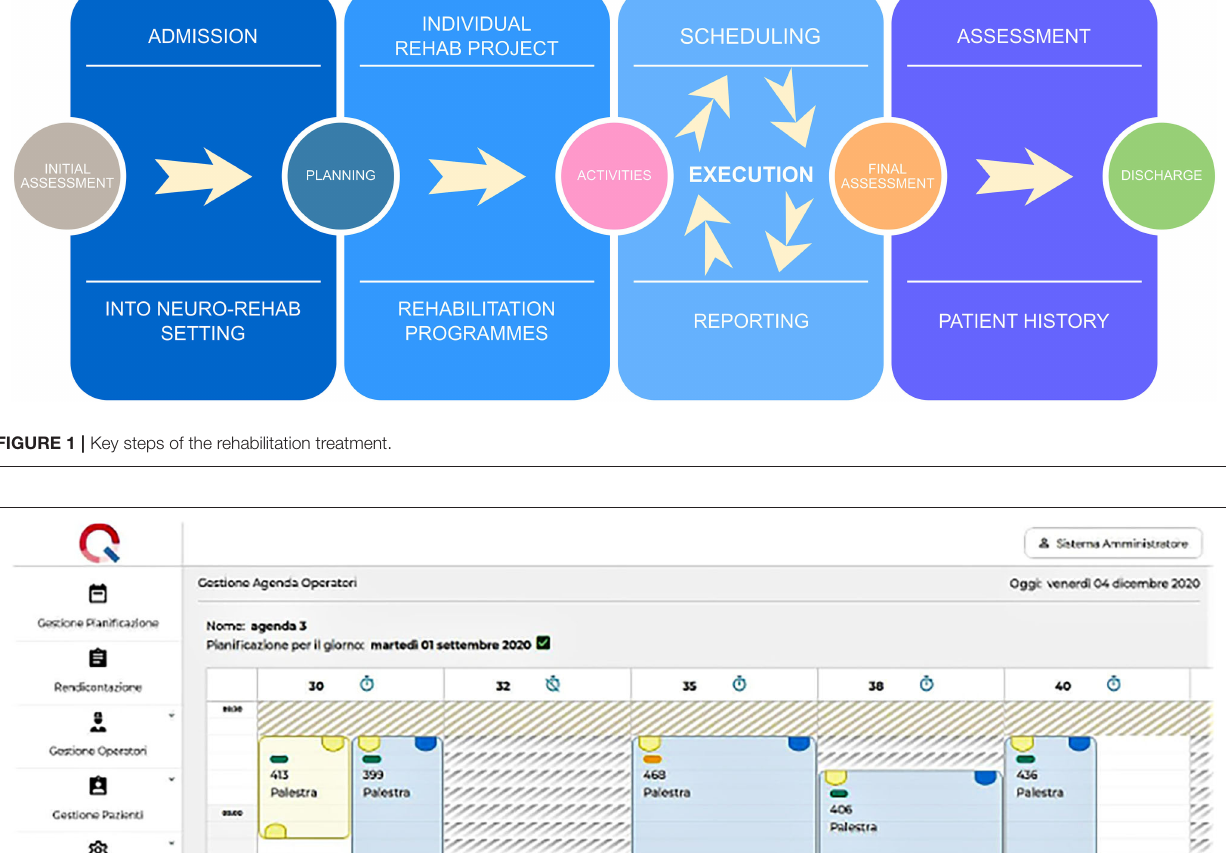
registered by the system and can be displayed as a summary of planned and delivered